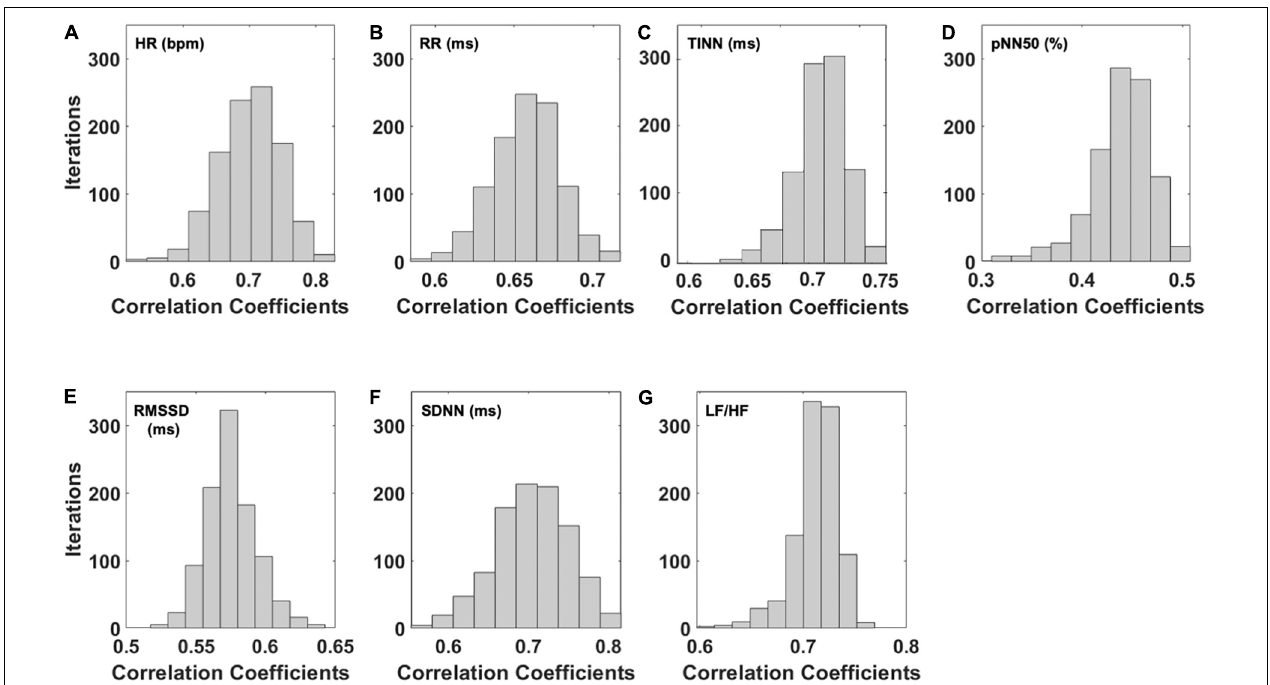
FIGURE 2 | Distribution of the correlation coefficients for the predicted HRV variables after 1,000 iterations of the bootstrap procedure. In detail, the distributions of the correlation coefficients obtained for the (A) heart rate (HR), (B) interval between consecutive R peaks (RR), (C) triangular interpolation of the NN interval histogram (TINN), (D) pNN50 (%), (E) root mean square of the successive differences (RMSSD), (F) standard deviation of NN intervals (SDNN), and (G) ratio of LF-to-HF power (LF/HF) are shown.